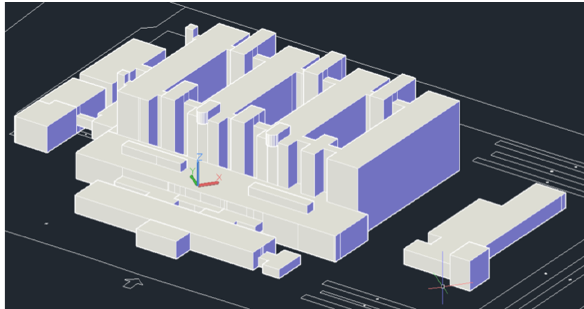
Figure 4. 3D model, Hospital Príncipe de Asturias, Alcalá de Henares.